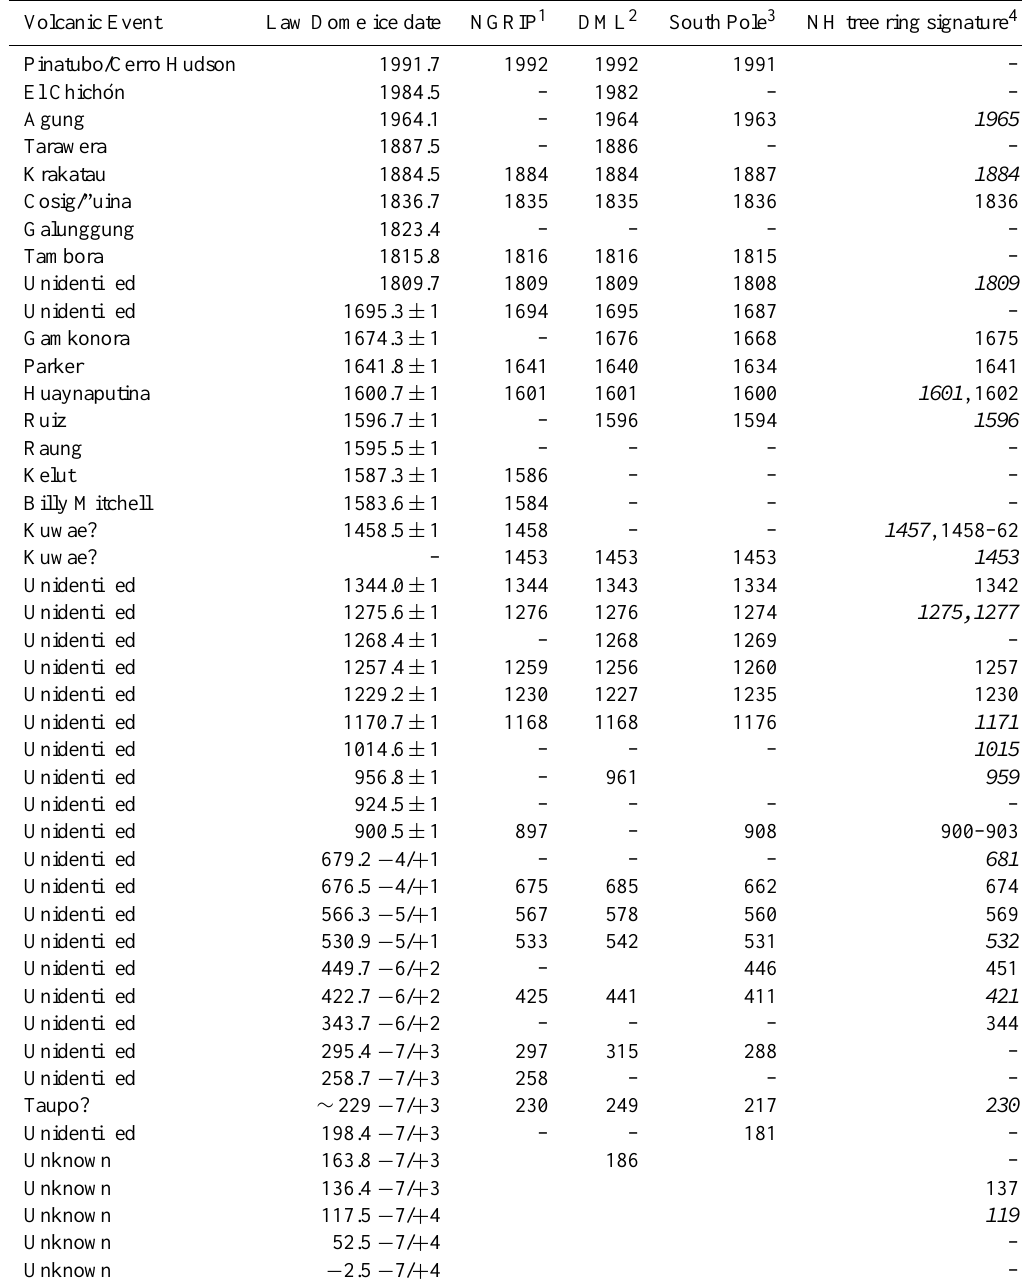
Table 1. Comparisons of the Law Dome volcanic event start dates with other independently dated records. Volcanic